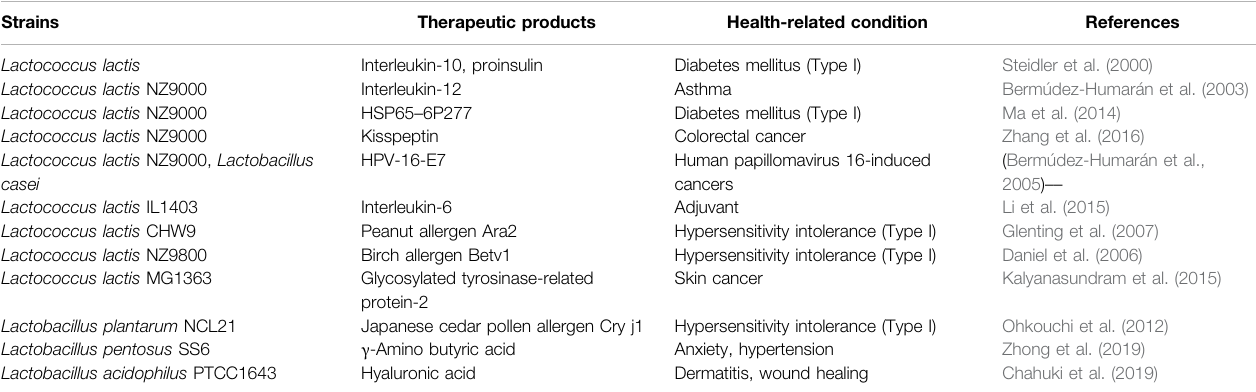
TABLE 4 | Summaries of available therapeutics from various recombinant